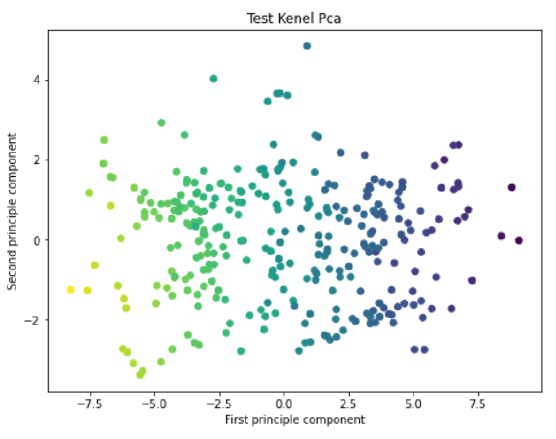
Figure 9. Test kernel PCA